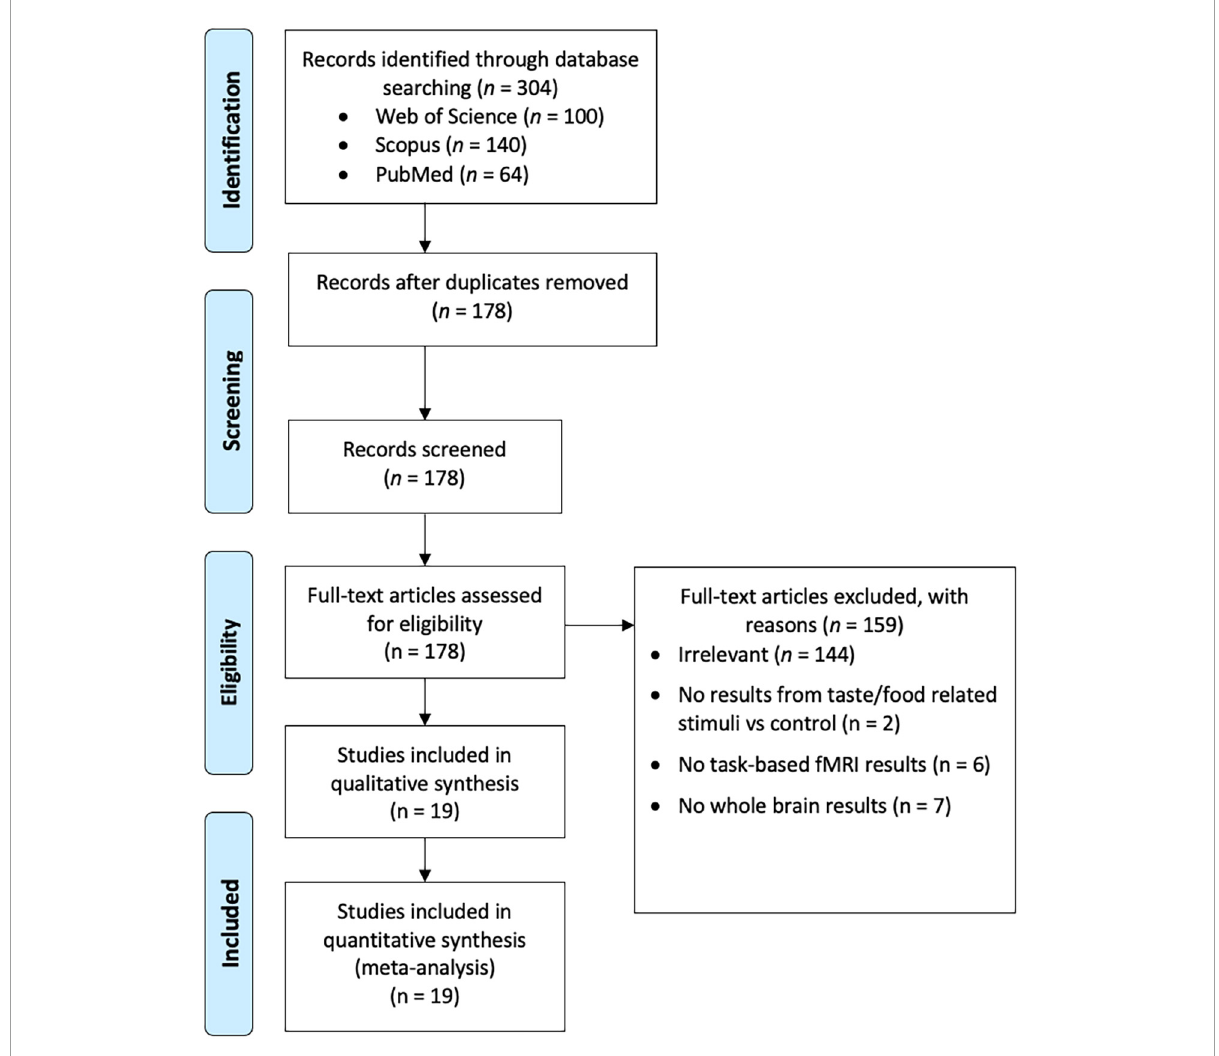
FIGURE1 A flow chart that illustrates the literature